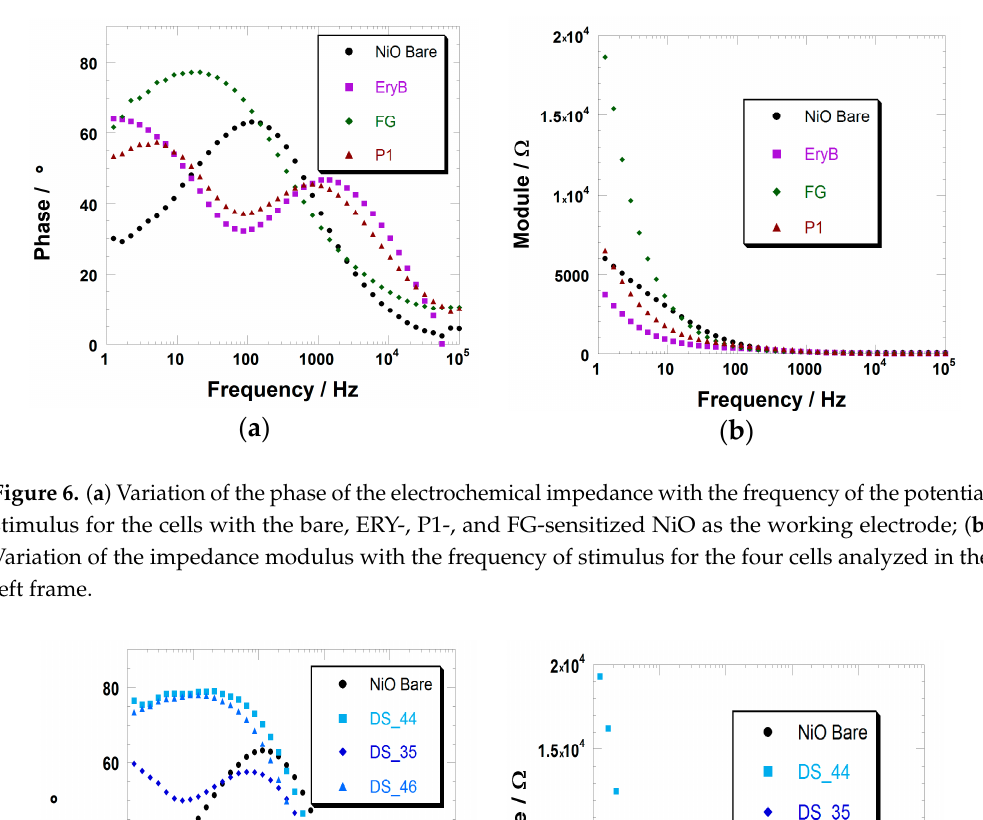
in the model of Figure 10. The fit of the impedance spectrum of the cell with the bare NiO as the working electrode was realized when R NiO/el = 4517 ± 53 Ω and the double-layer capacitance at the NiO/electrolyte interface C NiO/el was 8.06 ± 0.80 µ F. Table 2 lists the fitting values of the electrical parameters R NiO-D/el , R ct (Figure 10) and C NiO-D/el . The latter capacitive element refers to the charge distribution at the interface formed by the sensitized NiO electrode in contact with the electrolyte. The simulated impedance spectra are shown in the Supplementary Materials (Figures S13–S22).